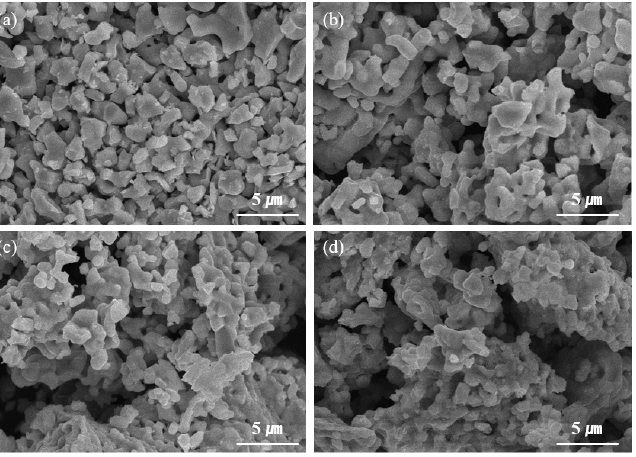
Figure 2. FE-SEM images of ( a ) YBC, ( b ) Li[YBC], ( c ) YEBCG, and ( d ) Li[YEBCG].